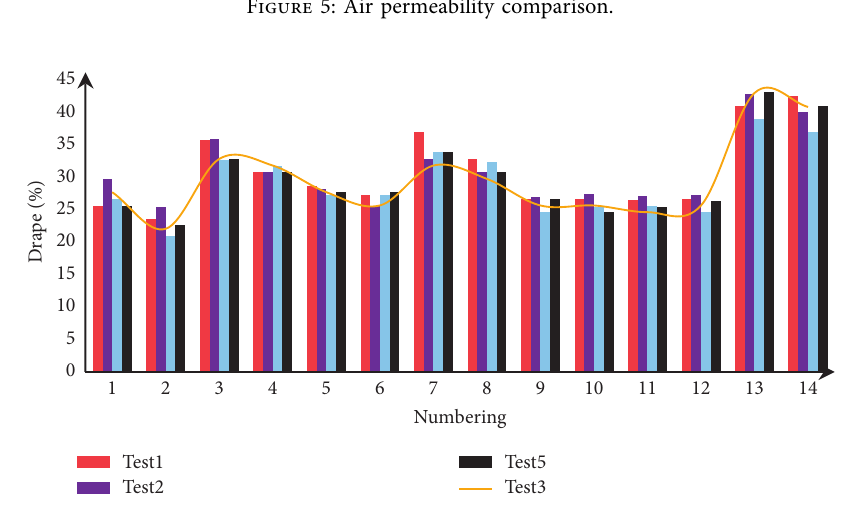
Figure 5: Air permeability comparison.